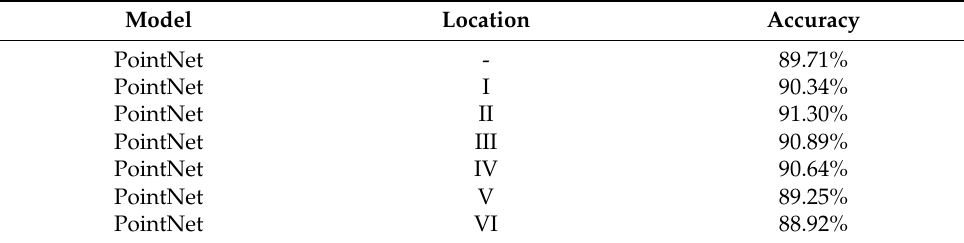
Table 3. Comparison of where attentional mechanisms are used in the model.